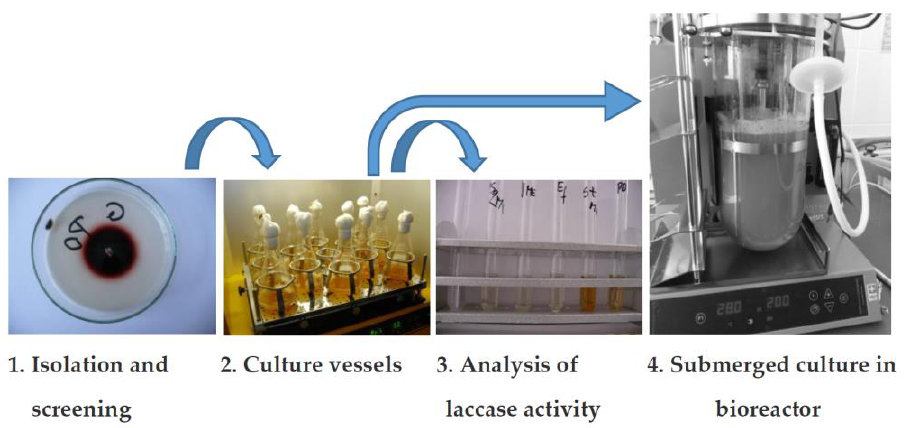
Figure 5. The stages of the biosynthesis process of laccases (authors creation).